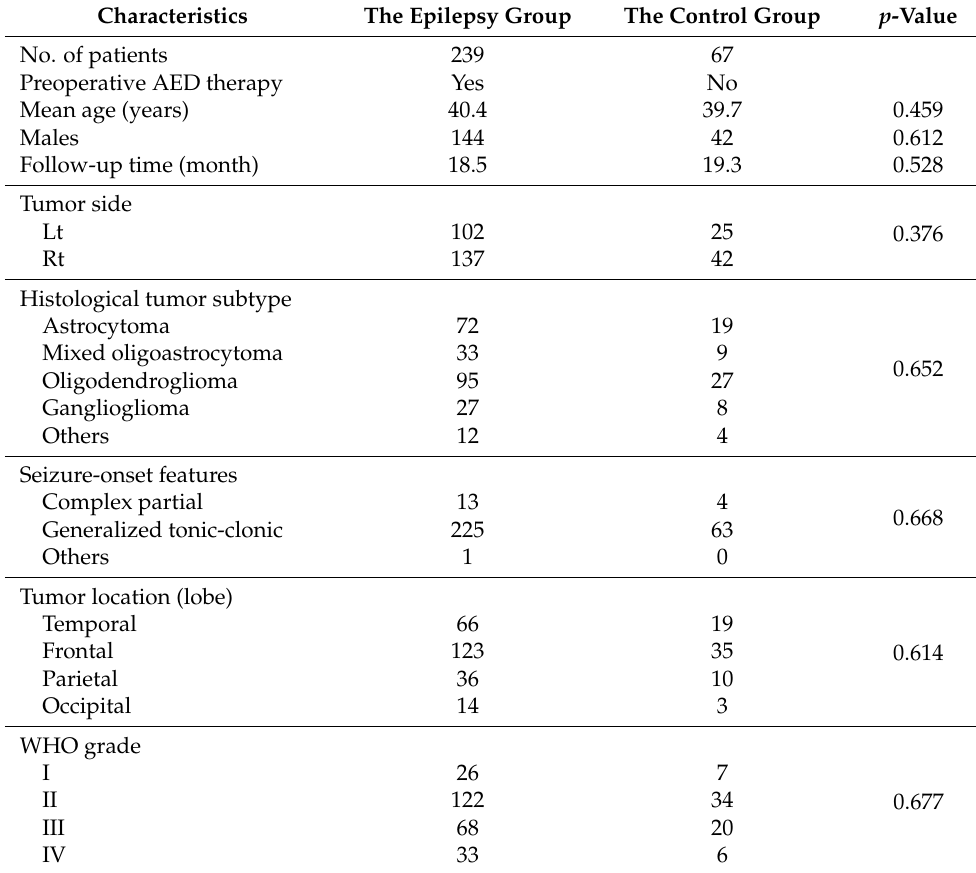
Table 1. The demographic characteristics of the epilepsy group and control group. Characteristics The Epilepsy Group